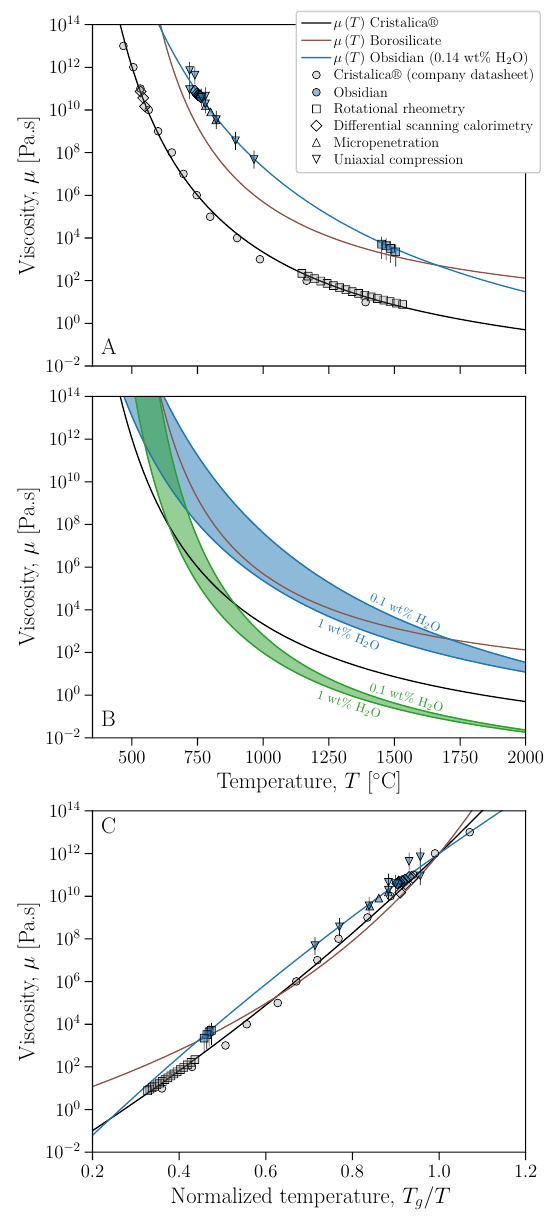
Figure 3: The viscosity of glass melts. [A] The temper- ature dependence of viscosity of Cristalica® and obsid- ian. Error bars are given as vertical lines through the data points where an experimental uncertainty is larger than the size of the data point. [B] A comparison be- tween the viscosity of the glass melts studied here and the temperature dependence of viscosity for metalumi- nous rhyolite (blue region) for 0.1 and 1 wt.% dissolved water concentration via a constitutive model [Hess and Dingwell 1996] and the temperature dependence of vis- cosity for a basaltic composition (green region) using a model for hydrous Etna composition [Giordano and Dingwell 2003] for 0.1 and 1 wt.% dissolved water con- centration. [C] The normalized viscosity via the method given by Angell